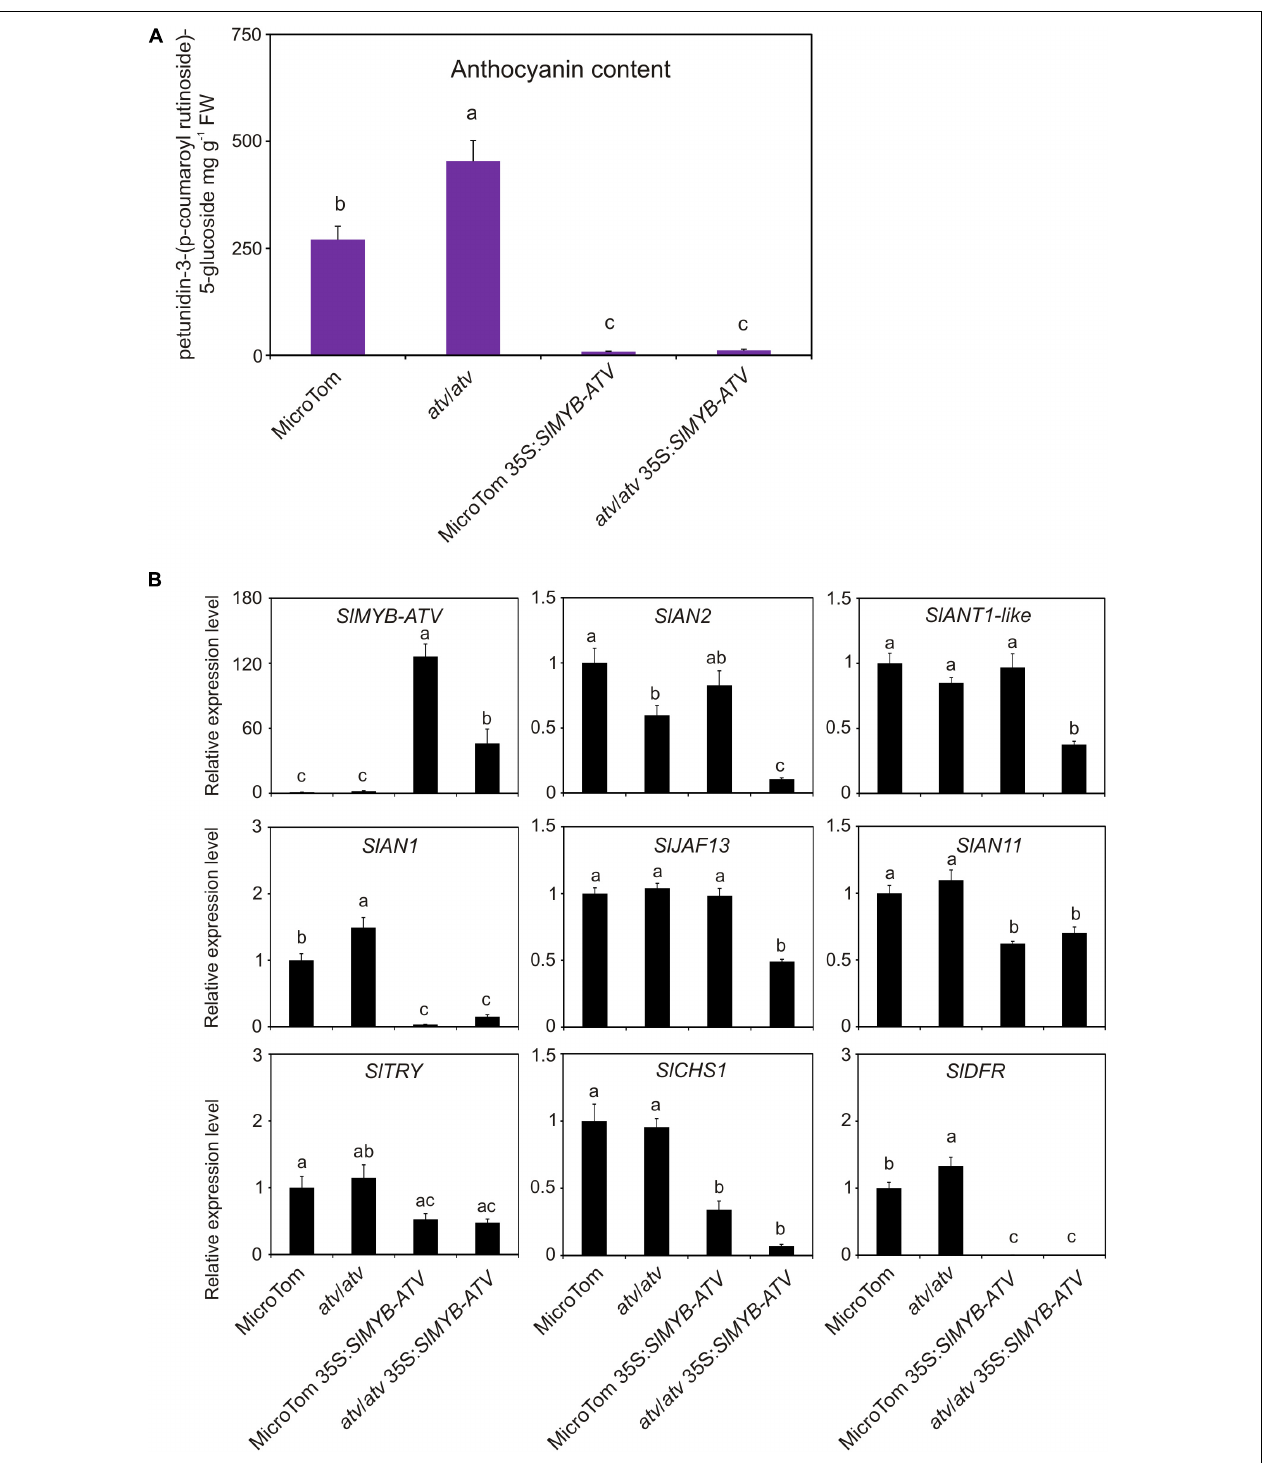
FIGURE 7 | Overexpression of SlMYB-ATV in tomato plants abolishes anthocyanin accumulation. (A) anthocyanin content measured in leaves collected from 4-week-old MicroTom (MT), 35S: SlMYB-ATV in MT, atv / atv (in MT background) and 35S: SlMYB-ATV in atv / atv plants. Anthocyanins are expressed in mg petunidin-3-(p-coumaroyl-rutinoside)-5-glucoside g − 1 fresh weight (FW). Data are means of three biological replicates (pooled leaf samples from three different 4-week-old plants/transgenic lines) ± SE. One-way ANOVA test (Tukey’s multiple comparisons test, P < 0.05) was carried out. Different letters indicate significant differences in each bar chart plot. (B) qPCR analysis of regulatory ( SlMYB-ATV , SlAN2 , SlANT1-like , SlAN1 , SlJAF13 , SlAN11 , SlTRY ) and representative structural genes ( SlCHS1 , SlDFR ) of the anthocyanin biosynthetic pathway. Data are means of three biological replicates (pooled leaf samples from three different 4-week-old plants/transgenic lines) ± SE. One-way ANOVA test (Tukey’s multiple comparisons test, P < 0.05) was carried out. Different letters indicate significant differences in each bar chart plot. Frontiers in Plant Science |